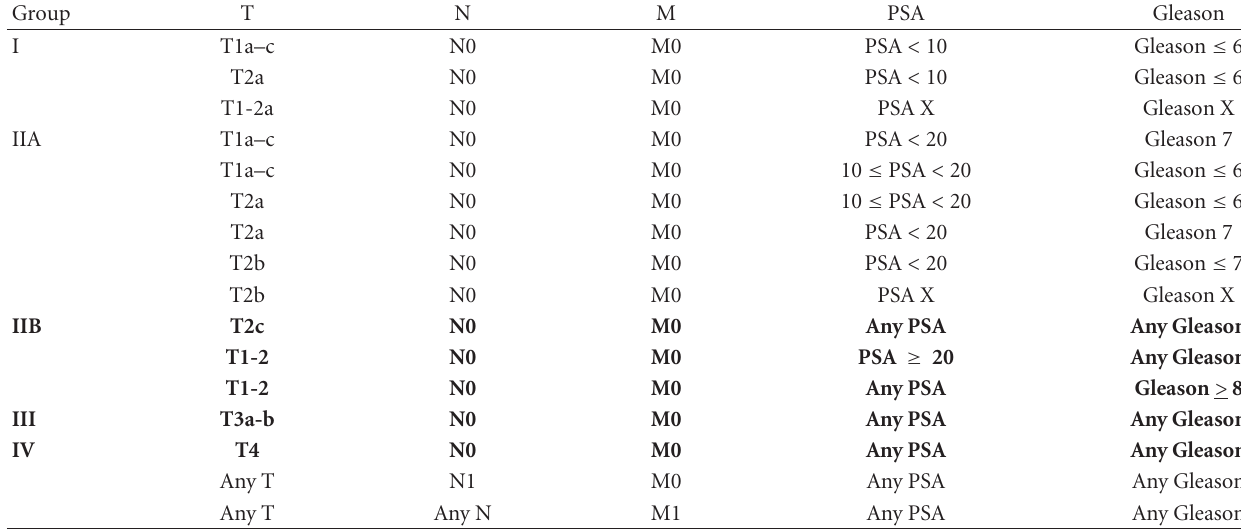
Table 1: Anatomic stage/prognostic groups, high-risk localized prostate cancer.